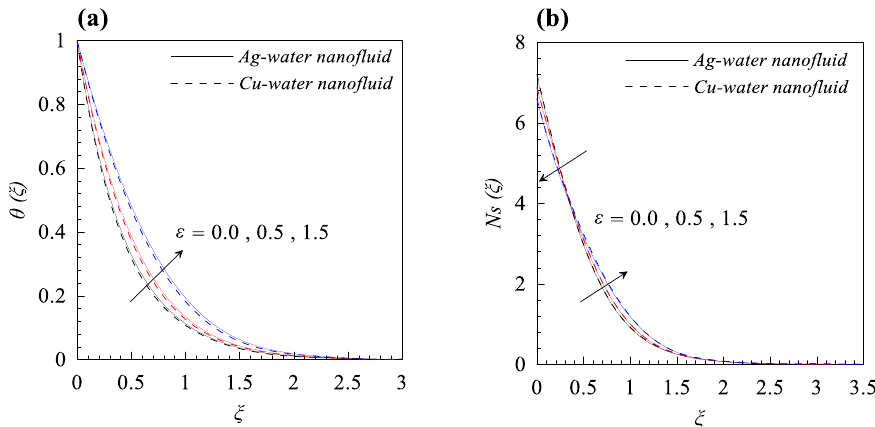
Figure 5. Effects of variable thermal conductivity parameter ε on ( a ) temperature distribution θ ( ξ ) and ( b ) entropy generation Ns ( ξ ) when κ = 10, M = 0.2, φ = 0.01, Ec = 0.3, and λ = 0.5.